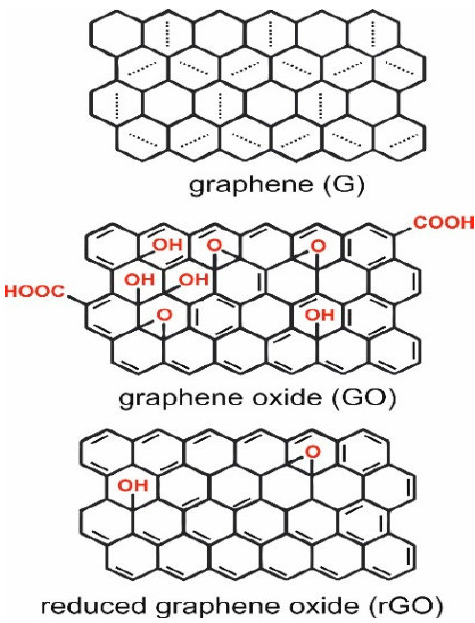
Figure 5. Structure of graphene, graphene oxide and reduced graphene oxide [66].